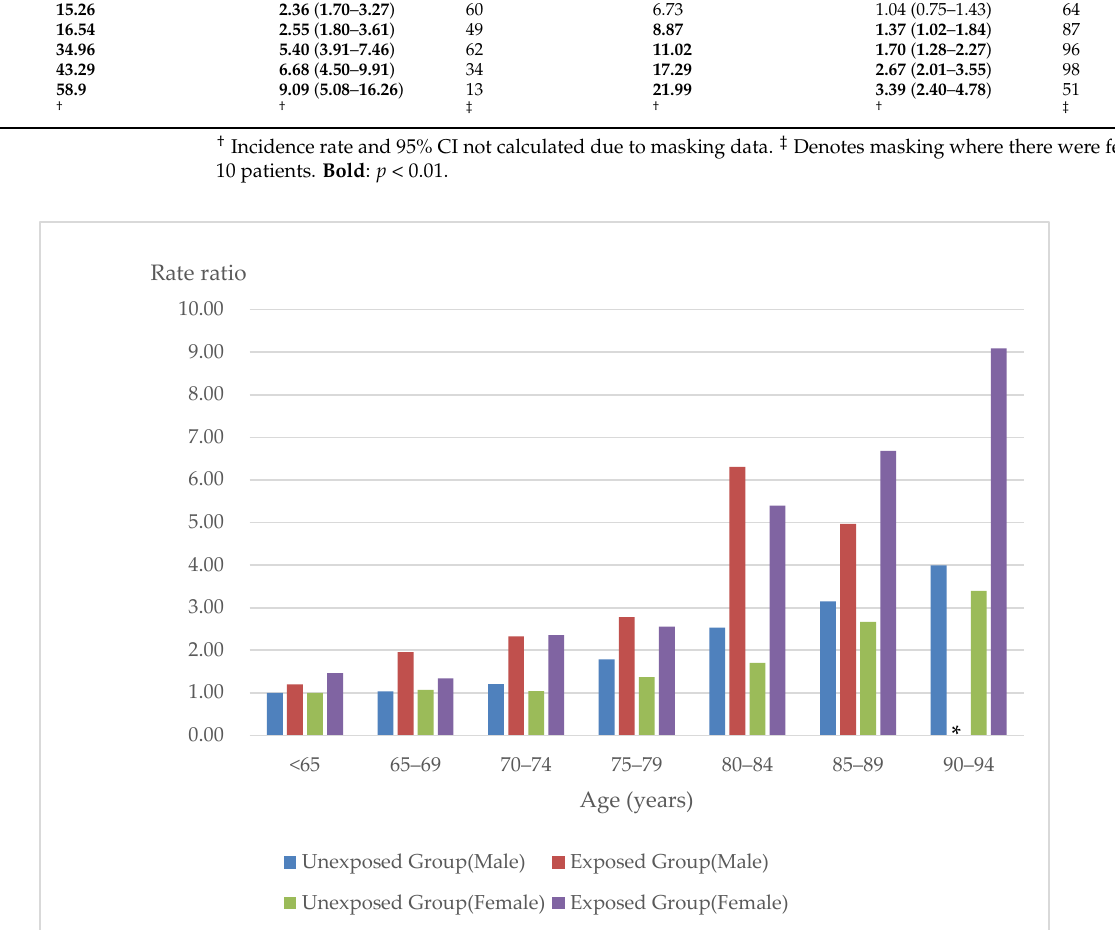
Figure 2. Rate Ratio of Lactic Acidosis by Age among Hospitalized DM Patients in Japan. * Denotes masking where there were fewer than 10 patients.